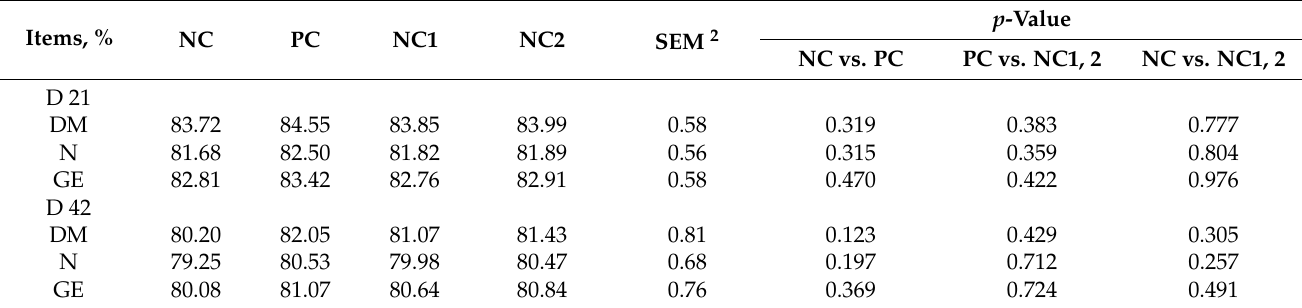
Table 3. Effect of dietary Lactobacillus plantarum BG0001 supplementation on nutrient digestibility in weaning pigs 1